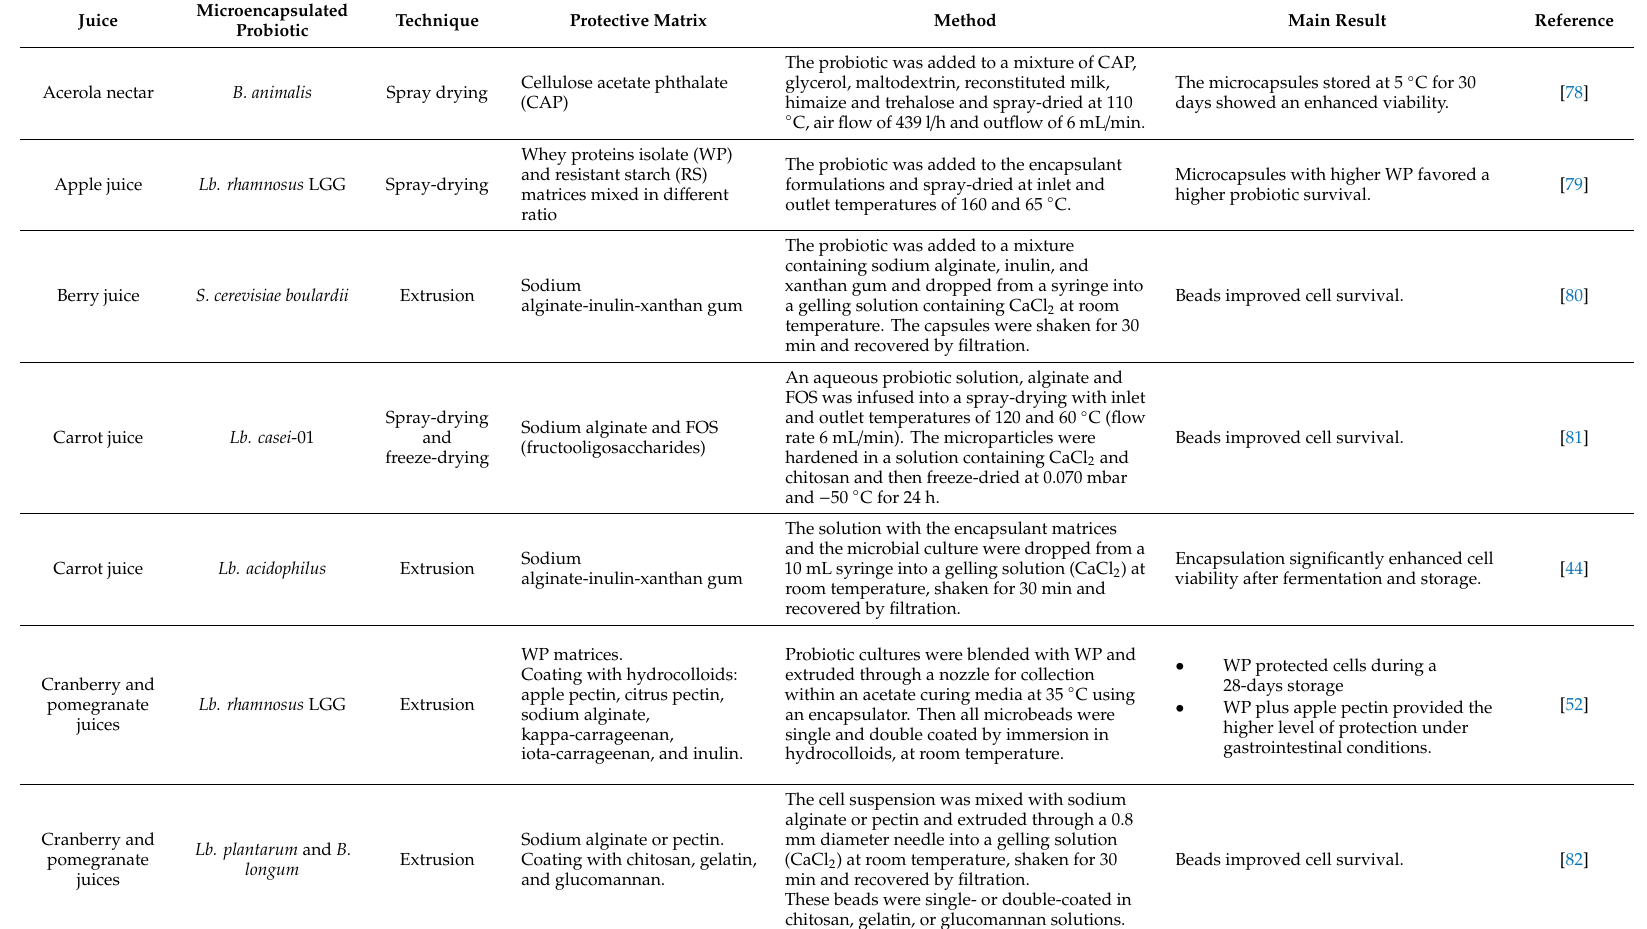
Table 3. Synopsis of the most recent research on the use of microencapsulated probiotics into functional beverages. B., Bifidobacterium ; Lb., Lactobacillus ; S., Saccharomyces